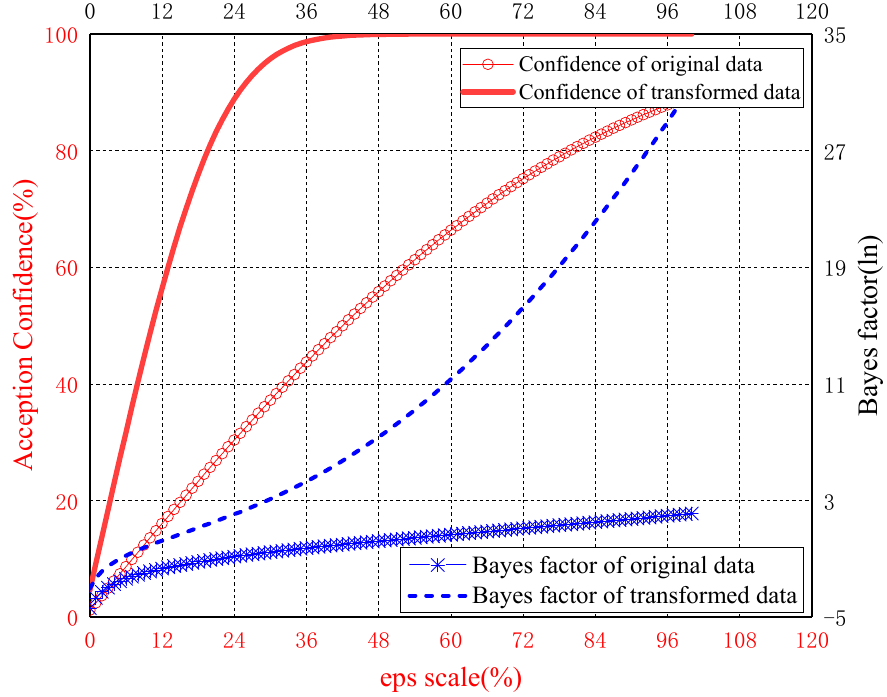
Figure 7. Effect of various ɛ values for the kriging model with original and transformed data.